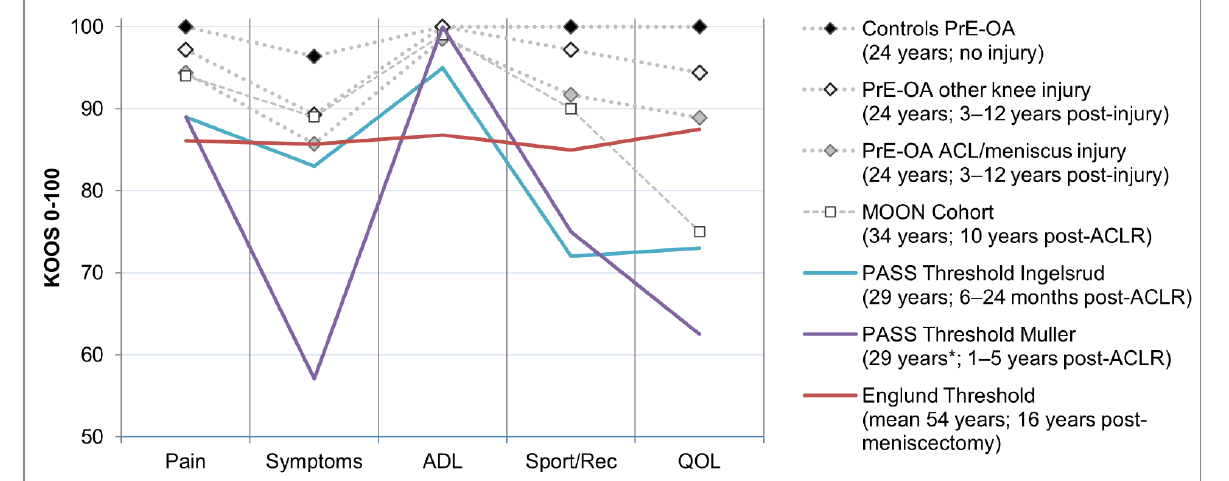
Figure 2. Median of KOOS subscales by injury type in the PrE-OA cohort compared to the Multicenter Orthopedic Outcomes Network (MOON) cohort and KOOS thresholds with median age and time since injury. * Estimate of age based on mean baseline age and time since injury.